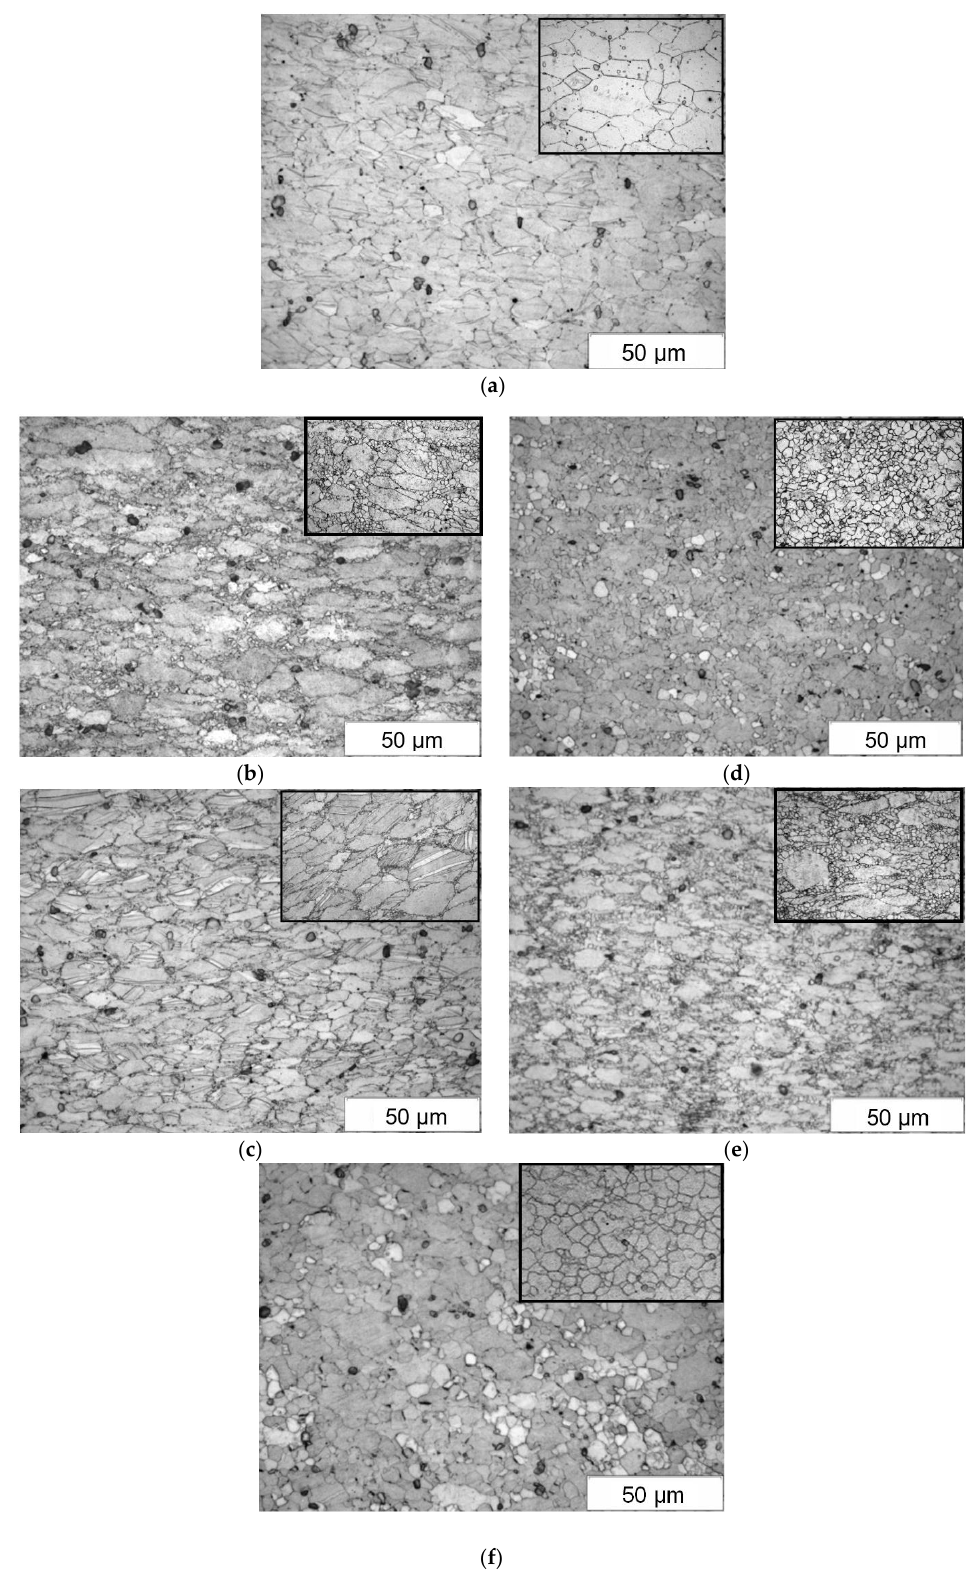
Figure 9. The microstructure of the investigated WE43 alloy after compression at a temperature of 250 – 400 °C and at a strain rate of 0.01 – 0.1 s −1 . ( a ) 250 °C — 0.01 s −1 ; ( b ) 300 °C — 0.01 s −1 ; ( c ) 300 °C — 0.1 s −1 ; ( d ) 350 °C — 0.01 s −1 ; ( e ) 350 °C — 0.1 s −1 ; ( f ) 400 °C — 0.1 s −1 .